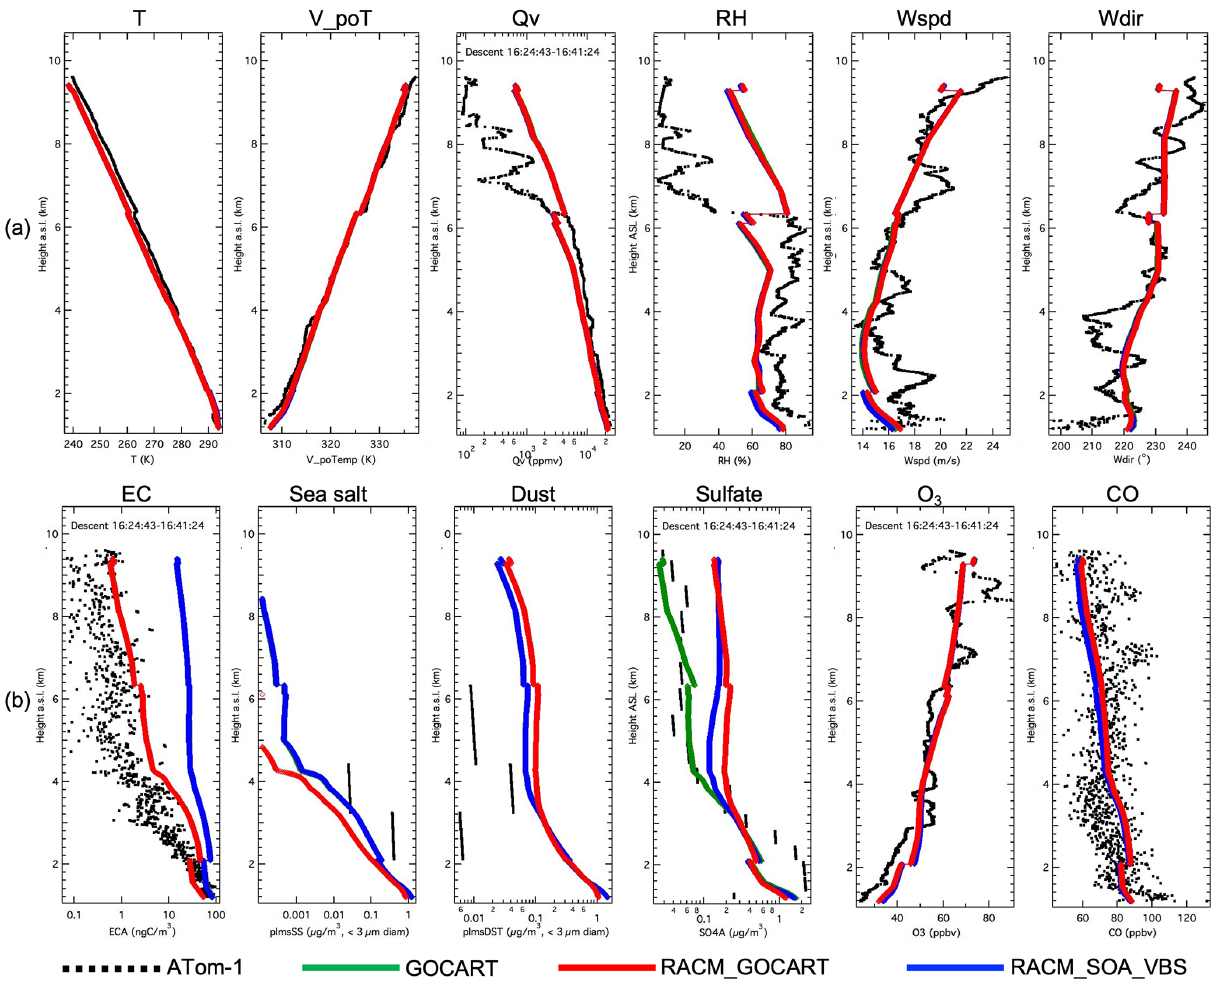
Figure 15. Observations and model results for profile no. 4 on 23 August 2016 over southeastern